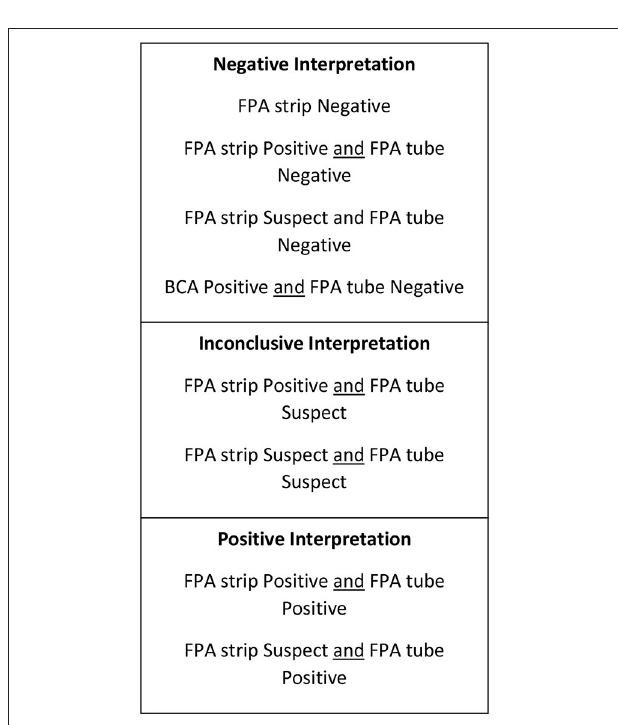
FIGURE 2 | Test interpretation utilized for serologic screening for the smooth strains of brucellosis ( Brucella abortus, suis, melitensis ).